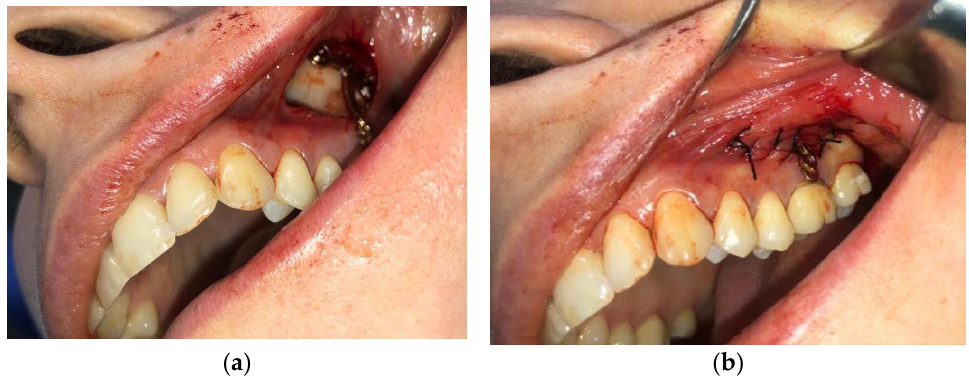
Figure 6. Zygomatic anchorage on the left maxillary buccal area: ( a ) with the exposure of the zygo- maticomaxillary buttress; ( b ) Nonresorbable 4/0 Supramid simple interrupted suture.